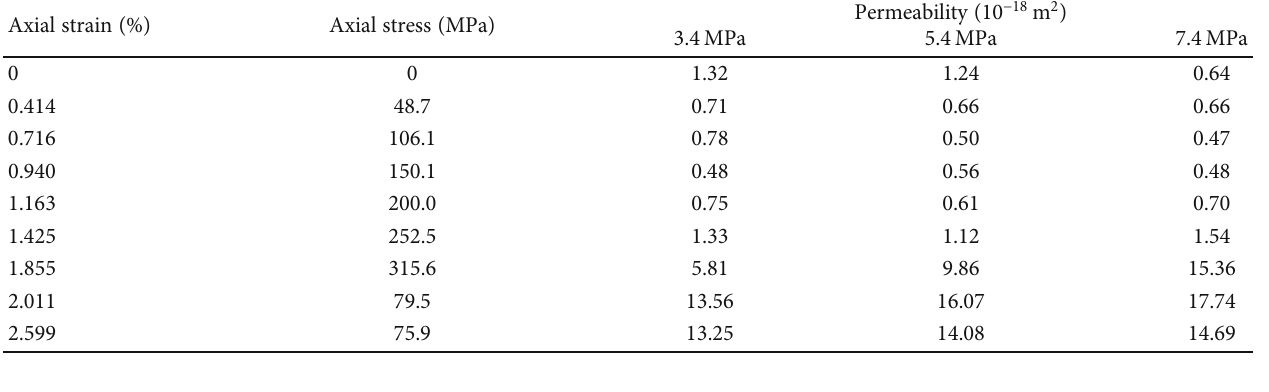
Table 2: Permeability test results for specimen BSS-2 for three di ff erent initial pressure di ff erences. Axial strain (%)